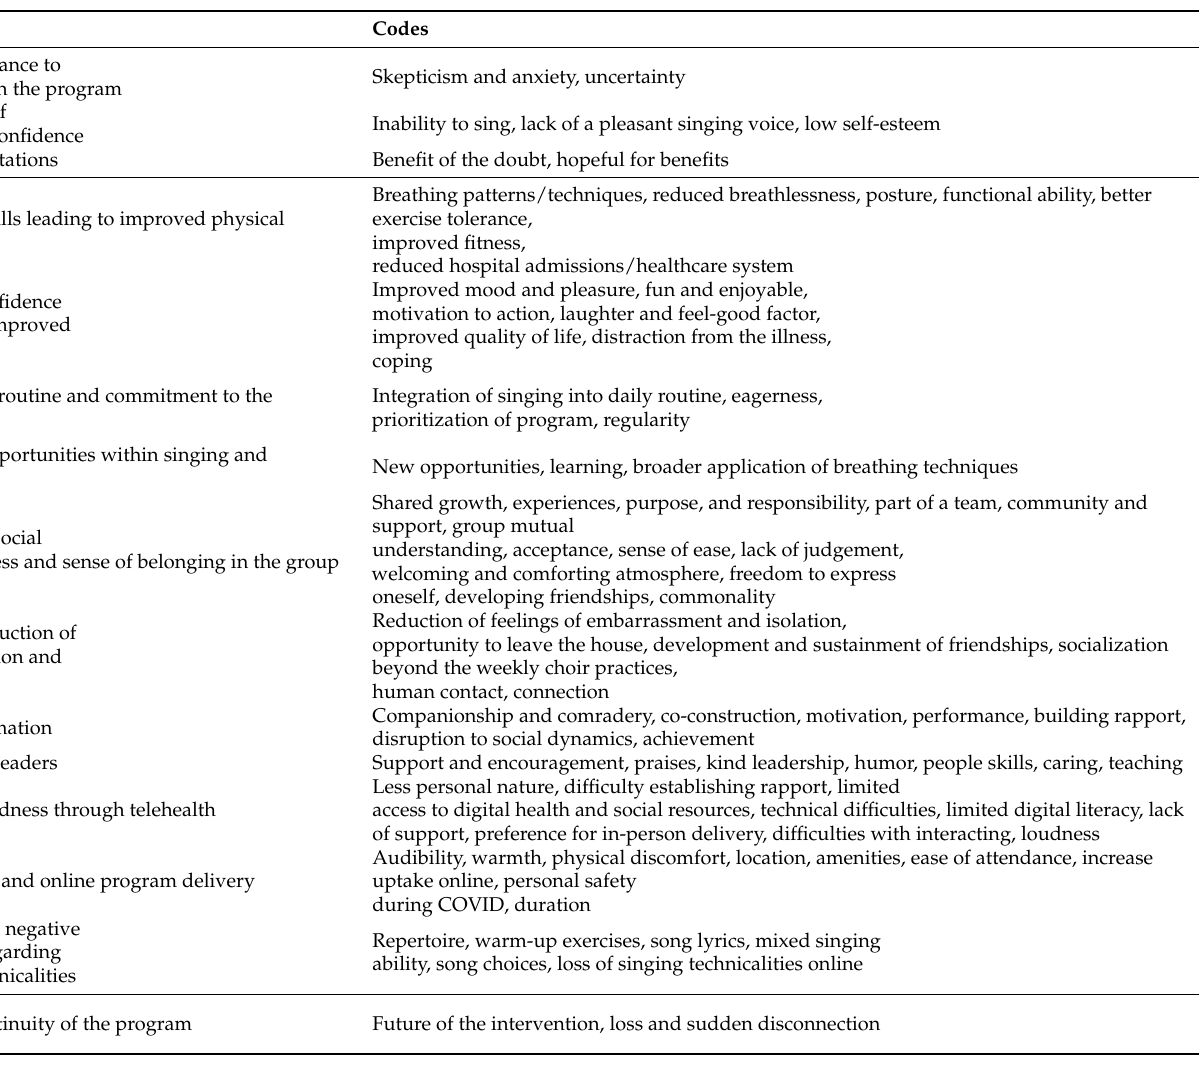
Table 3. Meta-synthesis